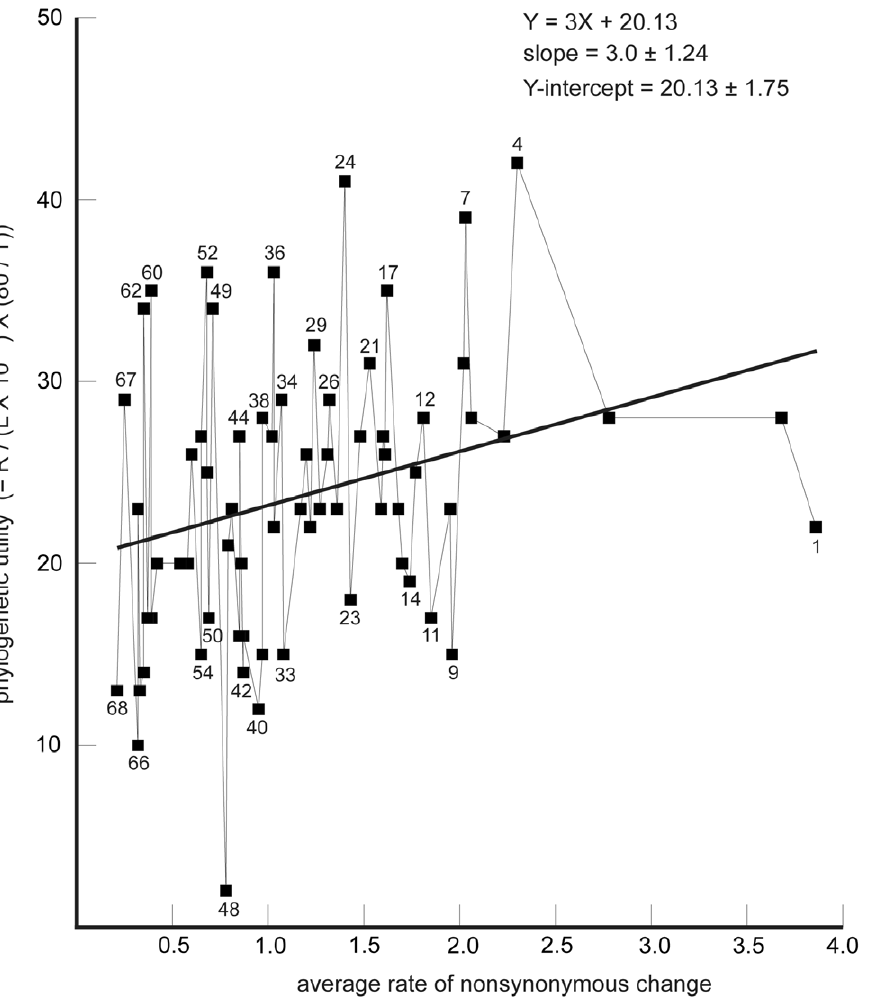
Figure 2. Phylogenetic utility of 68 gene segments plotted relative to its average rate of nonsynonymous change. As described in greater detail in Materials & Methods, phylogenetic utility (units are displayed on Y axis) is the number of taxonomic groups present in Figure 1 that are recovered with BP $ 75% / nucleotides sequenced for that gene segment 6 10 2 3 , corrected for the fraction of missing data. Units for the average rate of nonsynonymous change for each of the 68 gene segments (displayed on X axis) are the number of substitutions at nt2 per site across a 13- taxon tree, corrected for missing taxa (from Table 2 in [5]). The straight line y = bx + c that best fits the data, using linear regression, is shown, together with values for the slope ( 6 1 standard deviation) and the Y-intercept ( 6 1 standard deviation).. For convenient cross-reference and identification, individual gene segments are numbered (1=fastest, 68=slowest) as in Table 2 of Regier et al., 2008 [5].